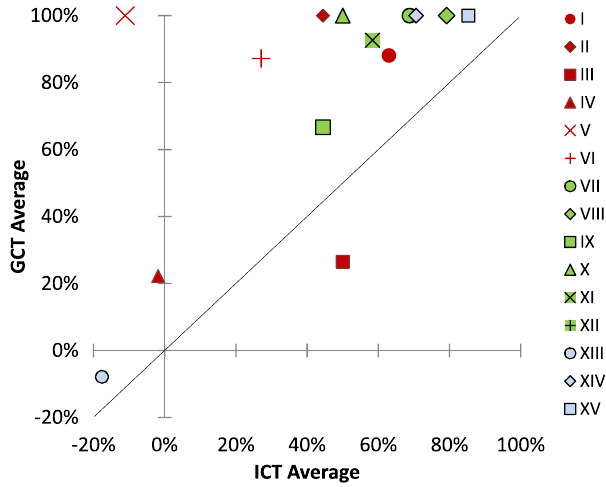
FIG. 6. Average scores on the comparison questions for the GCT vs the ICT. Error bars are not shown for clarity; the average standard error was (cid:2) 7 % for the ICT and (cid:2) 8 % for the GCT.